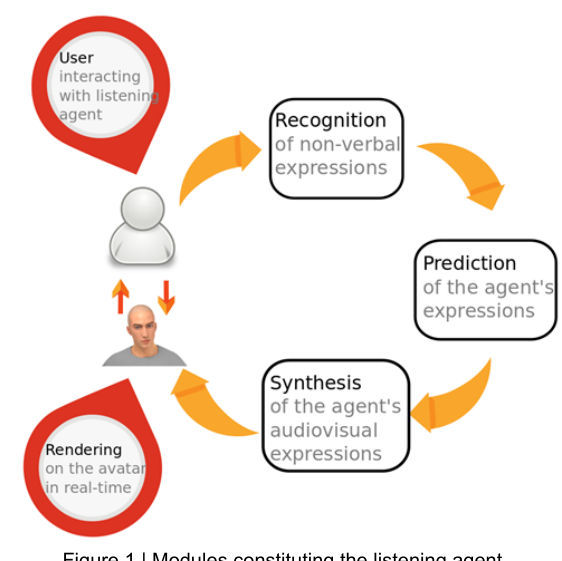
Figure 1 | Modules constituting the listening